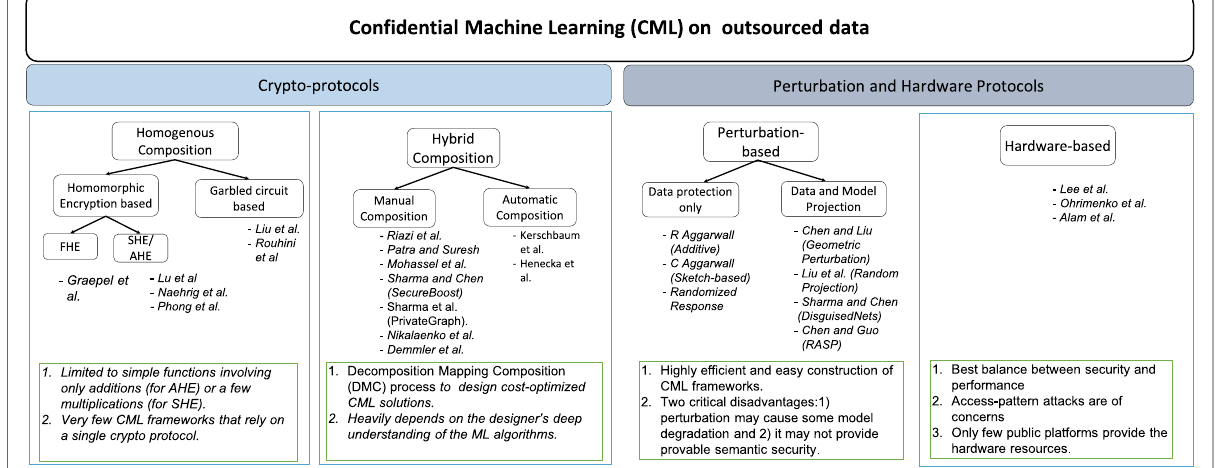
Fig. 3 The systematization framework for confidential machine learning (CML)